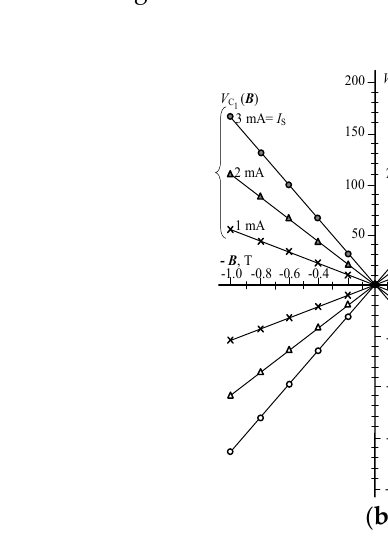
Figure 2. ( a ) Output characteristics V C1,4 ( B ) ≡ V H ( B ) of the new HD, the offset is compensated in advance. The obtained magnetosensitivity is about S RI ≈ 110 V/AT at temperature T = 20 °C; ( b ) Individual sensitivities on the two contacts C 1 and C 4 of the HD assessed by potentials V C1 ( B ) and V C4 ( B ), respectively are equal, S RI ≈ 55 V/AT.